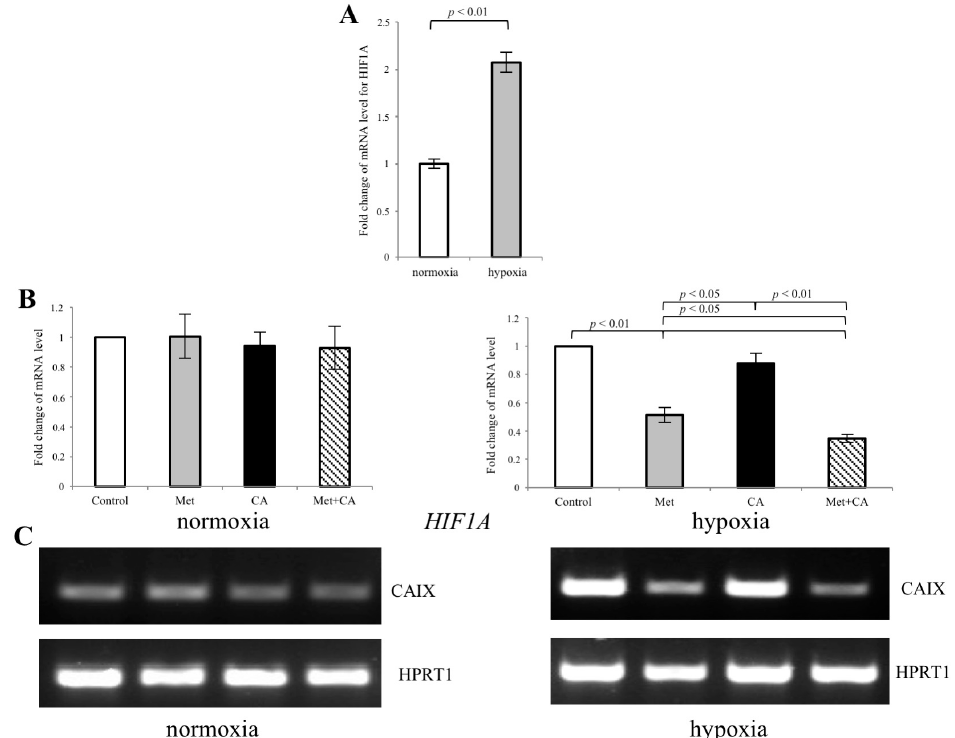
Figure 8. Met inhibits the expression of CAIX in HTB-35 cells under hypoxic conditions. The cells were incubated either in normoxia (21% O 2 level) or in hypoxia (5% O 2 level) with CA, Met or both compounds for 24 h. qPCR analysis was performed to assess the expression of HIF-1 α under normoxic and hypoxic conditions ( A ). The RNA expression of HIF1A was determined with the 2 −ΔΔ C t method. The mRNA level of HIF1A was significantly increased following hypoxia (( A ), p < 0.01 vs. control). On the contrary, Met alone and together with CA downregulated HIF1A (( B ), p < 0.01 vs. control for Met, p < 0.01 vs. control for CA/Met). RT-PCR analysis revealed that in hypoxia the expression of CAIX significantly decreased in cells exposed to Met and CA/Met (( C ), HPRT1 was a reference gene). Data shown here are representative of three experiments performed with similar results ( C ).